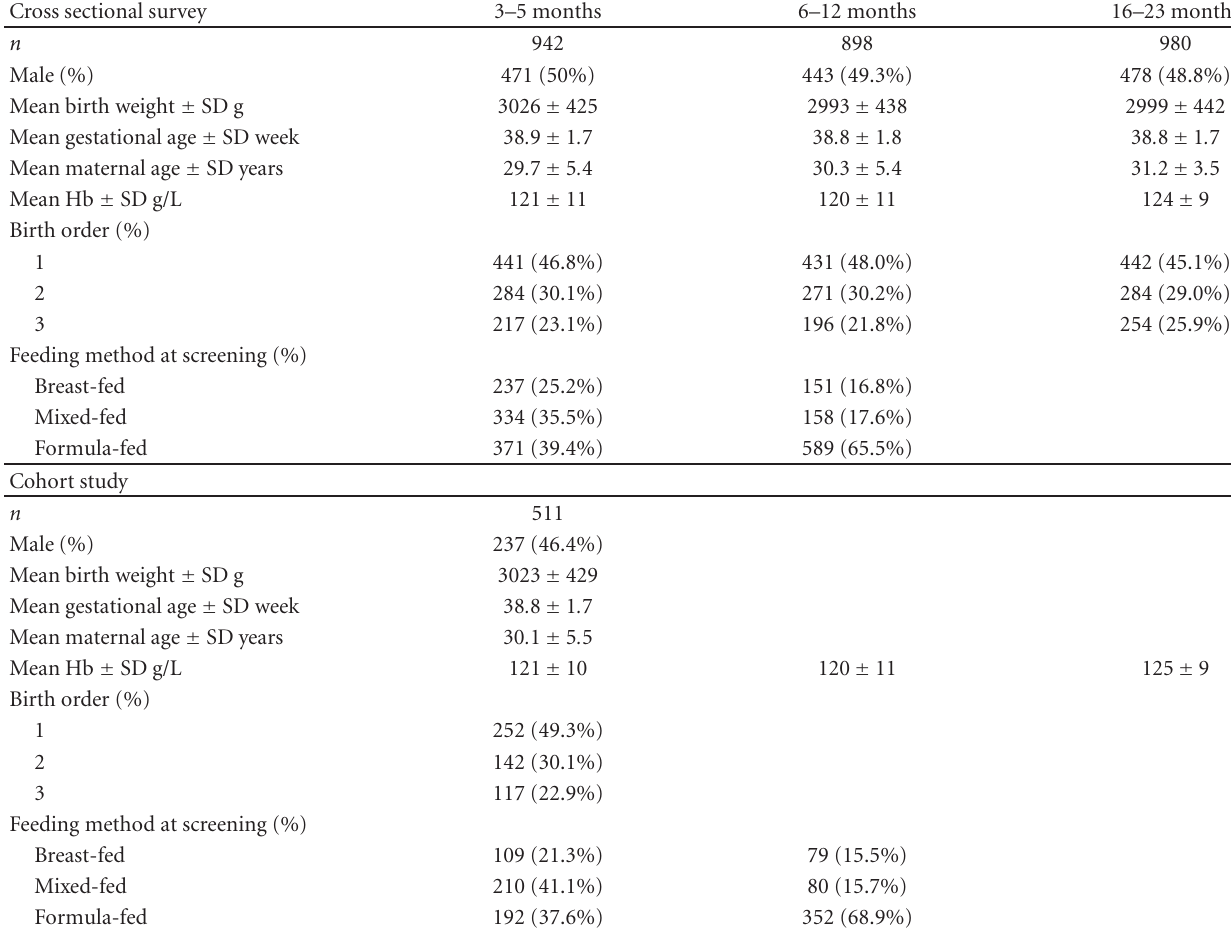
Table 1: Characteristics of infants in the Okinawan village,